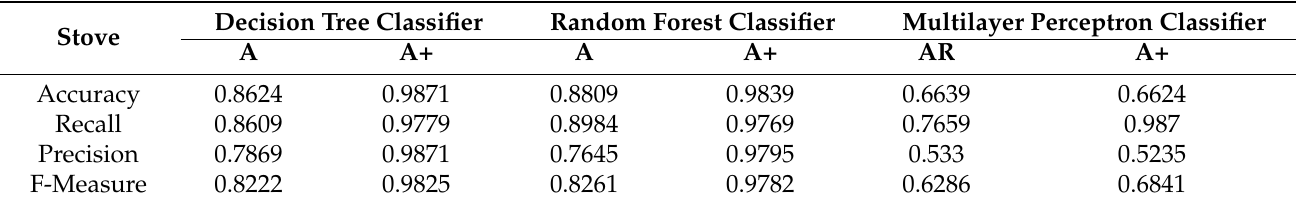
Table 3. Results for the stove. With “A” we refer to the experiments that used only active power. With “AR” we refer to experiments with active and reactive power and with “A + ” we refer to experiments with all the selected attributes.